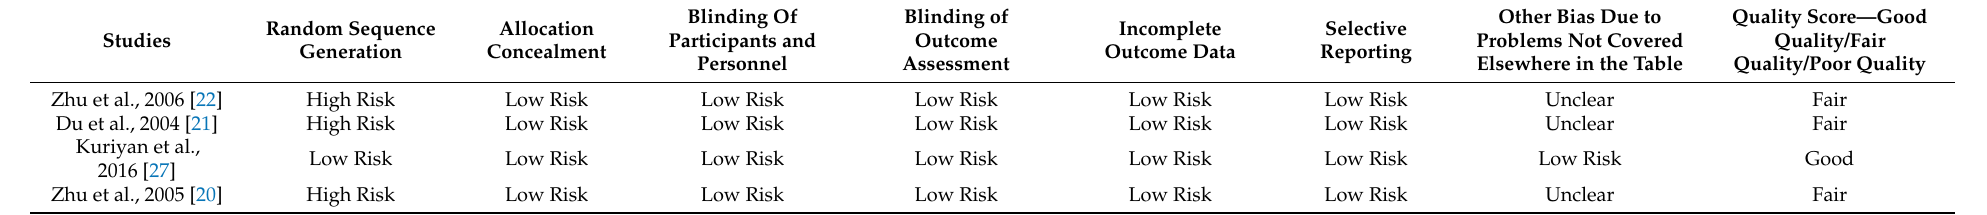
Table 6. Quality assessment of randomised controlled